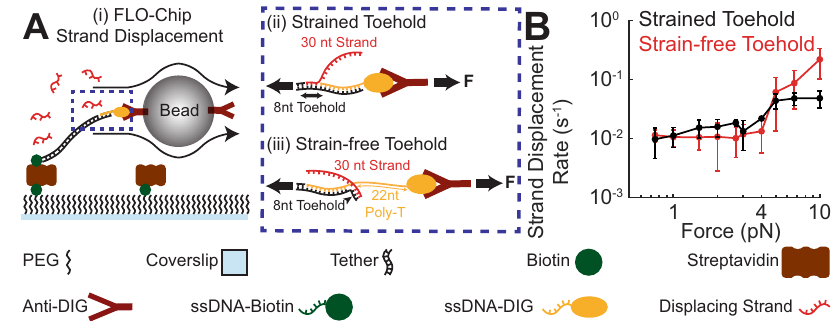
Fig. 5 | Investigating the impact of toehold strain on strand displacement reaction rate using FLOChip. A i) Schematic demonstrating implementation of FLOChiptoinvestigatestranddisplacementreactionrateunderforce.ii)Schematic of the con fi guration that enables application of force to both the toehold and the branch migration domain. iii) Schematic of the con fi guration that enables the applicationofforcetoonlythebranchmigrationdomainwhilethetoeholddomain remains strain-free. B Impact of strain on toehold-mediated strand displacement reaction rate under 0.75 – 10pN force range under Strained Toehold (both the